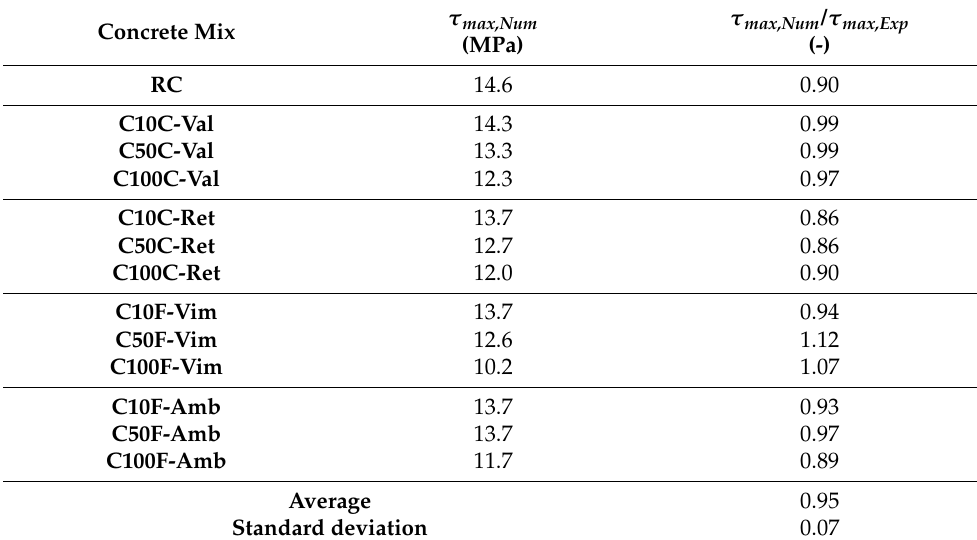
Table 10. Numerical bond strength of the concrete mixes with RA from CDW. Concrete